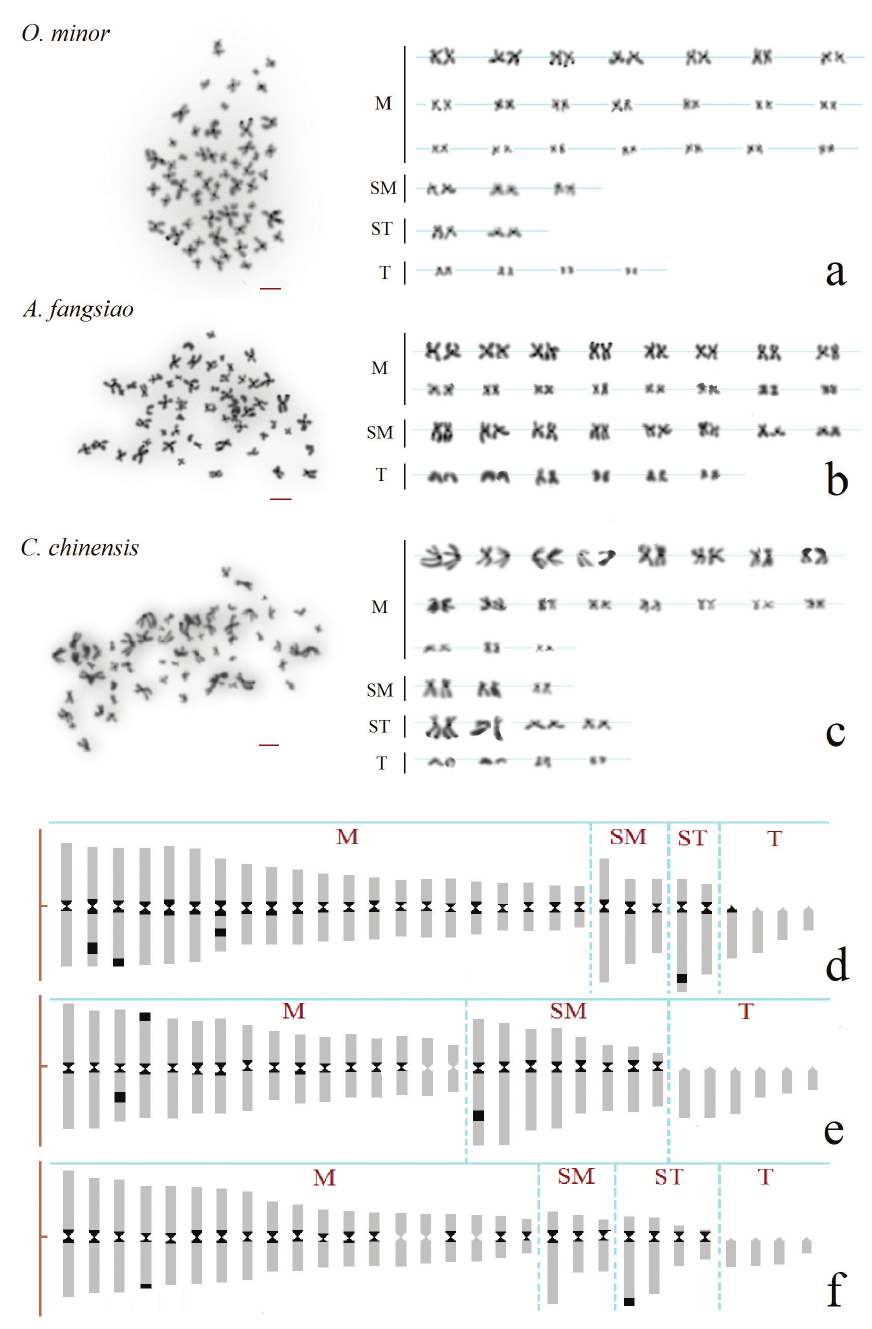
Figure 3. C-banding karyotypes arranged from mitotic metaphases of O. minor ( a ), A. fangsiao ( b ) and C. chinensis ( c ) and diagrams of C-banding ( d, e, f ). Black dots representing the chromosomes with C bands/heterochromatin blocks. Scale bars: 5